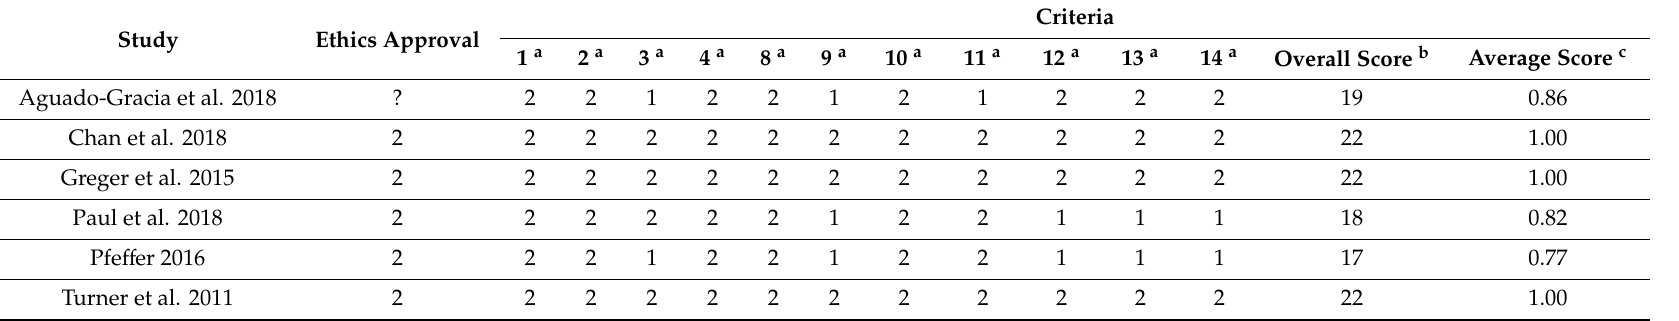
Table A2. Detailed quality assessment of included